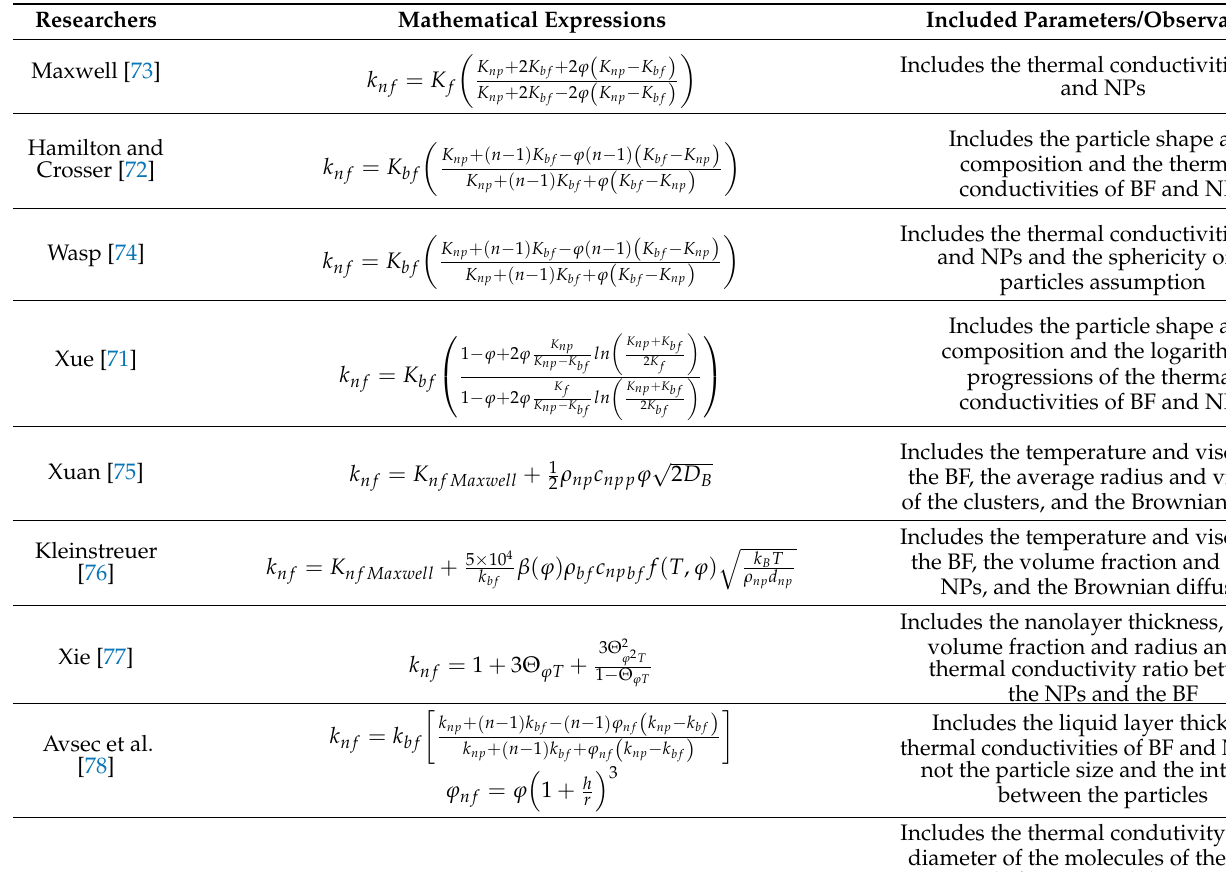
Table 1. Representative thermal conductivity empirical models (Adapted and abridged from